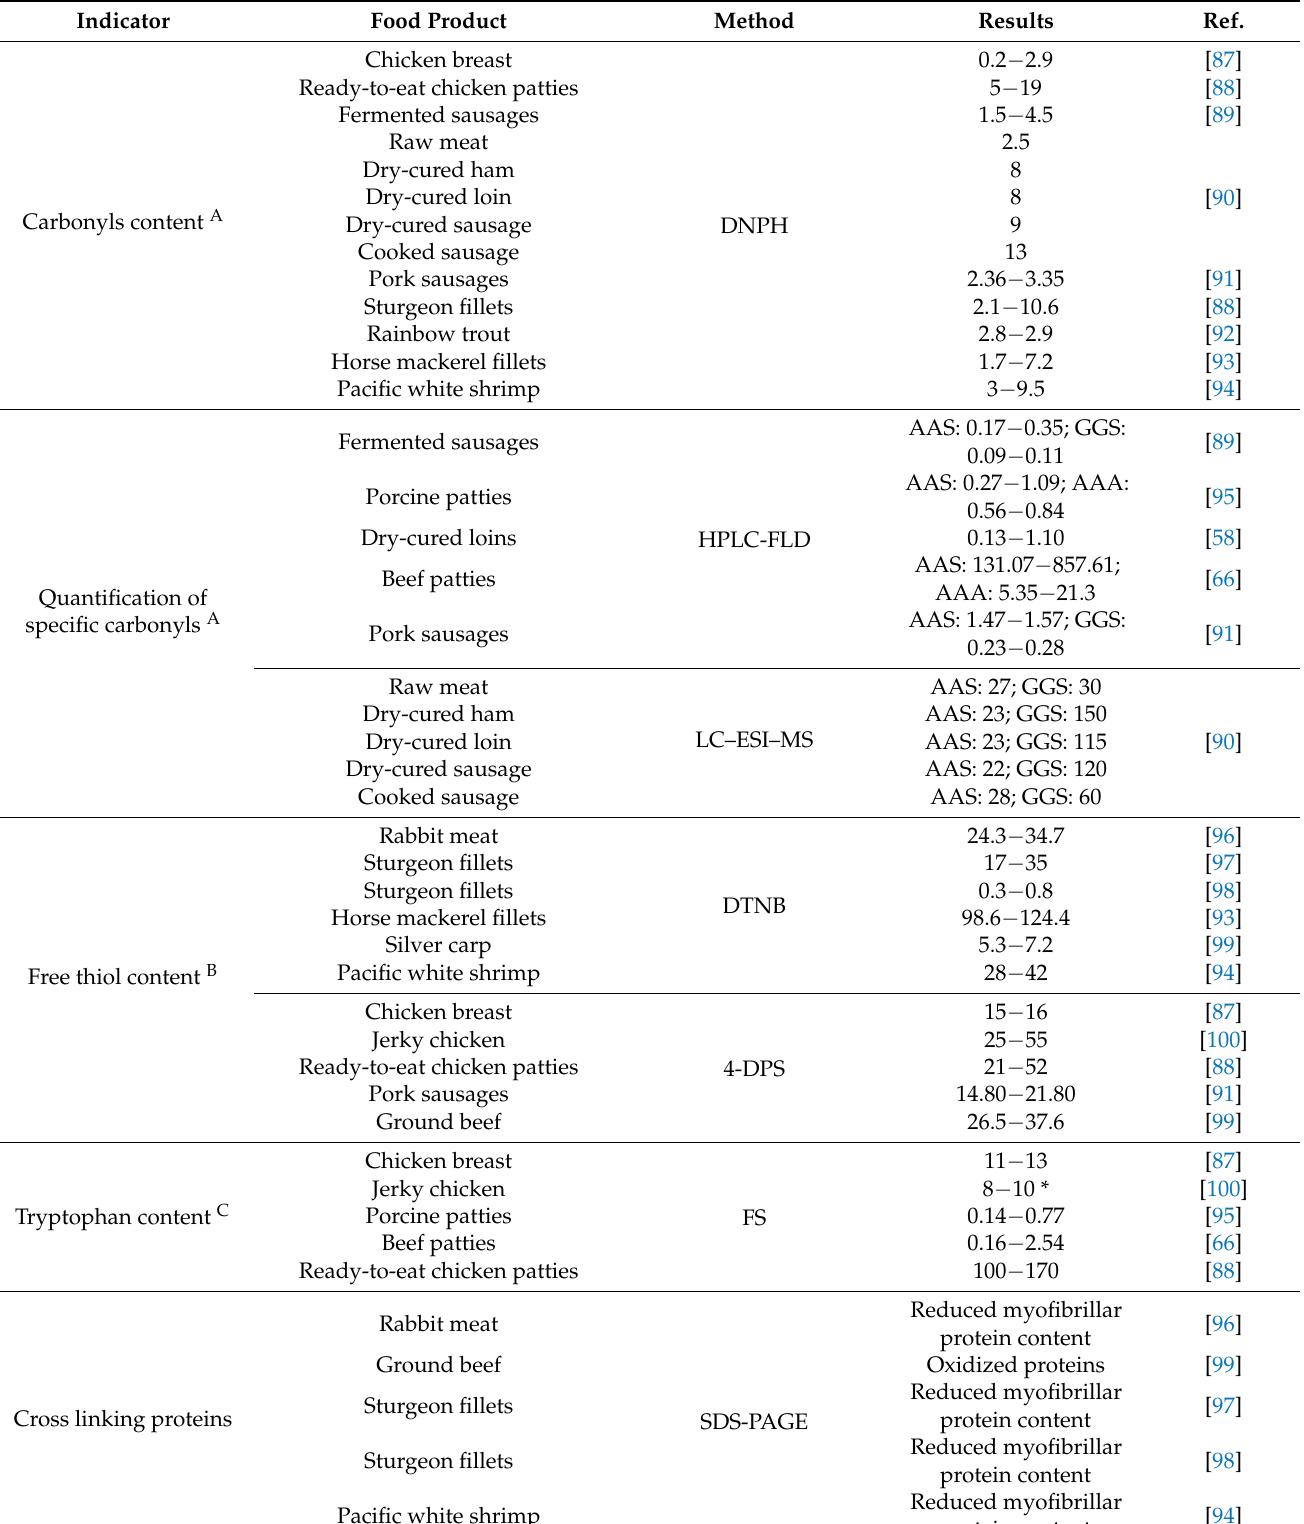
Table 2. Studies evaluating protein oxidation in different muscle